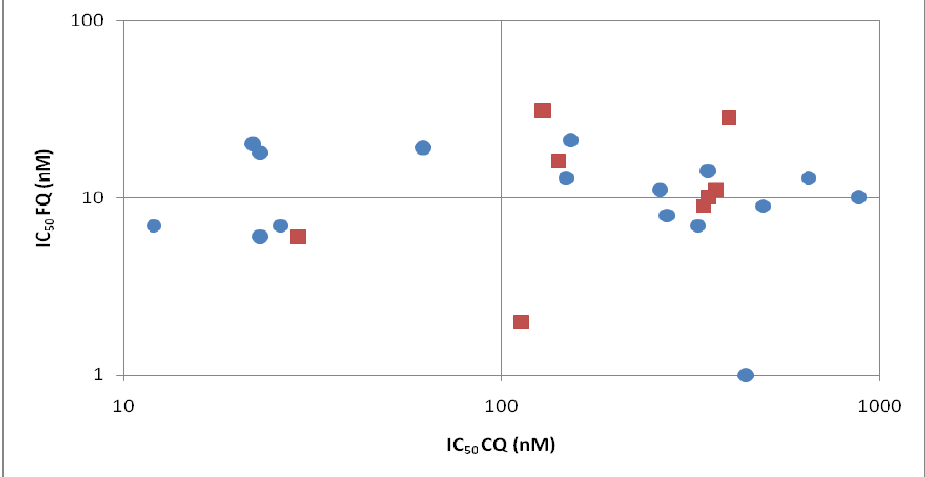
Figure 2. Comparison of in vitro sensitivity to CQ and FQ on 16 different laboratory P. falciparum clones (blue circles) and on eight sets of field isolates from Gabon, Senegal, and Cambodia (red